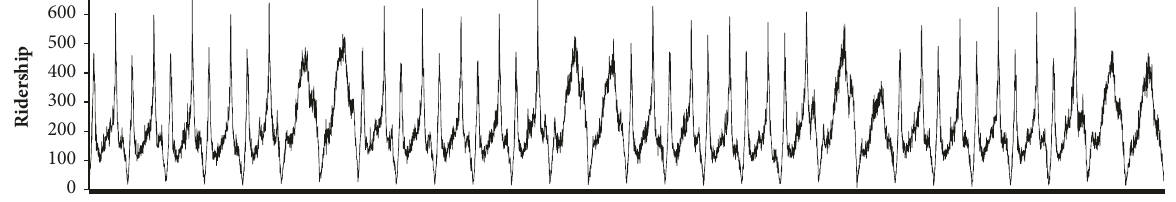
Figure 3: The origin entrance ridership time series at Sanshanjie Station of Nanjing Metro from November 5 to December 2, 2012.